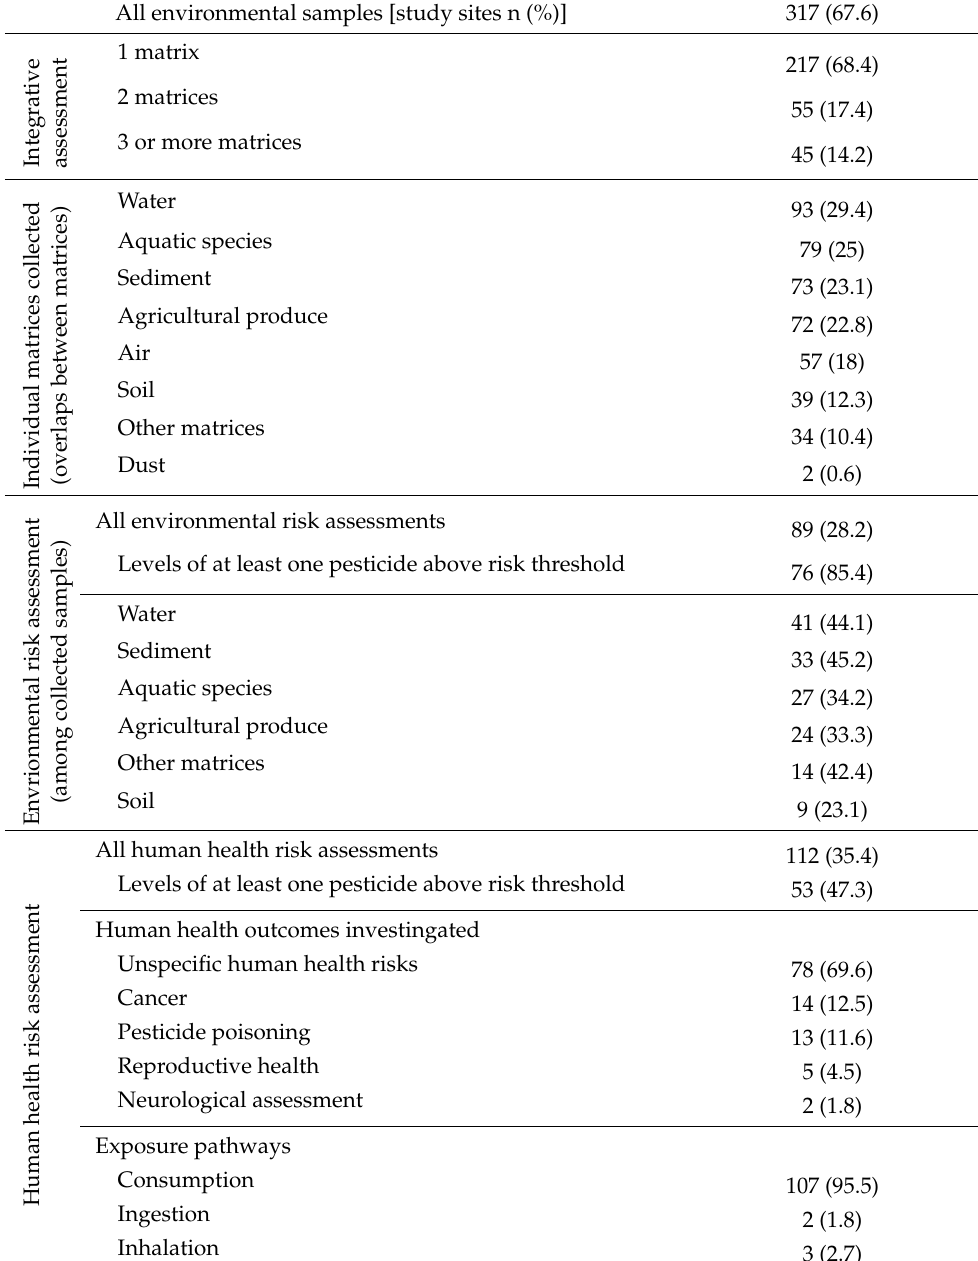
Table 3. Characteristics among the 469 study sites that collected environmental